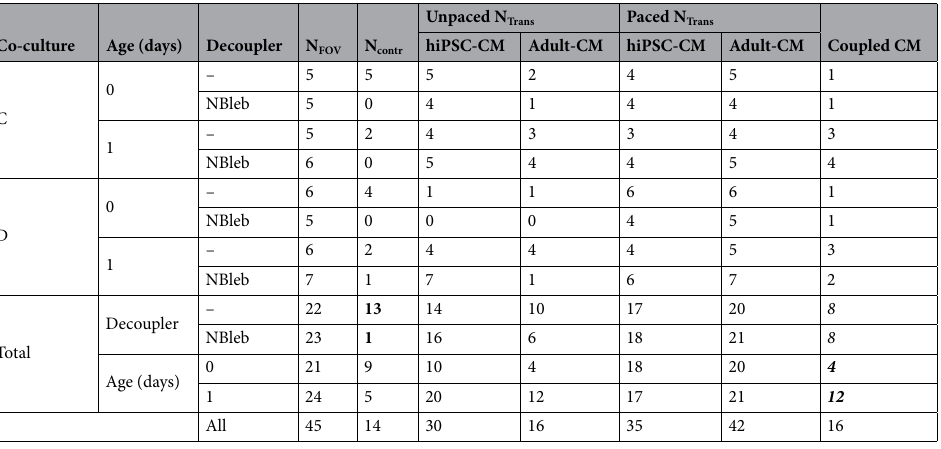
cells and hiPSC-CM at equivalent stages of differentiation presenting a logistical challenge due to their periodic availability. In future investigations, exploring the coupling interaction between species-matched iPSC-CM and